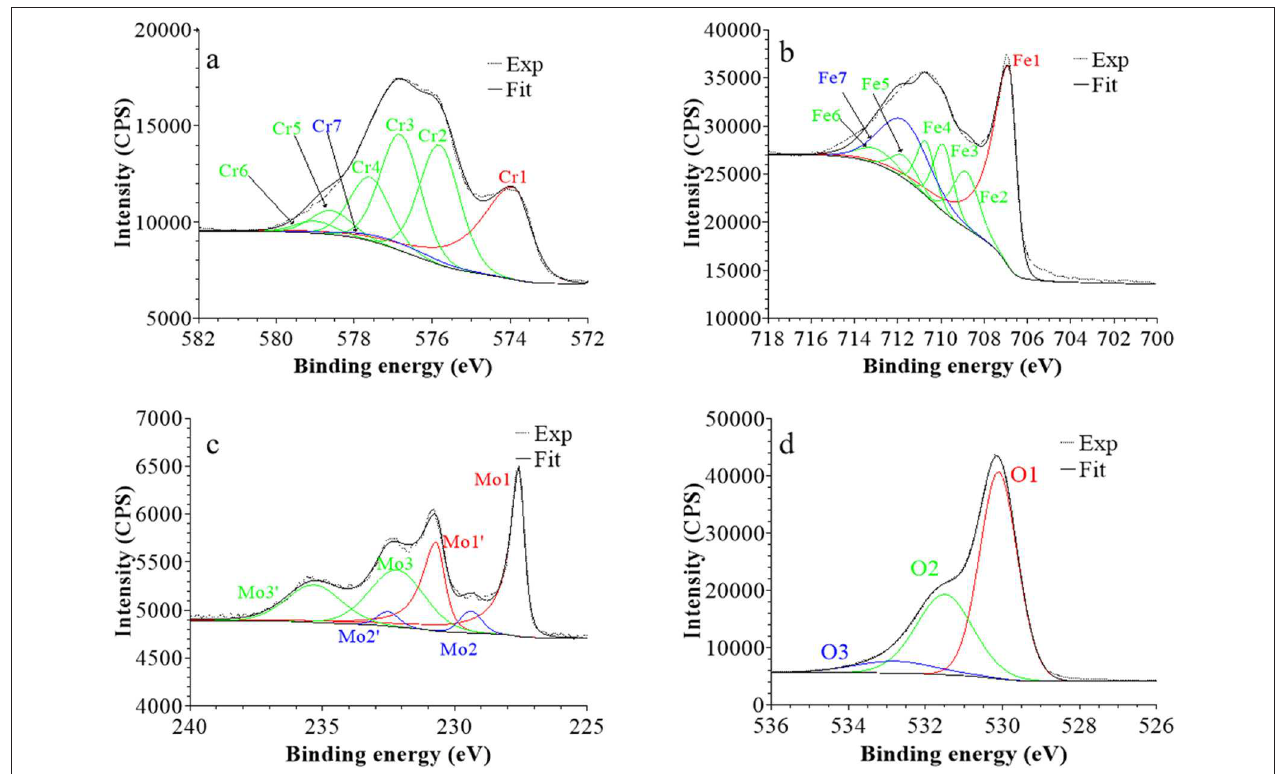
FIGURE 5 | XPS core level spectra and their reconstruction for the native oxide film on 316L SS: (a) Cr 2p 3 / 2, (b) Fe 2p 3 / 2, (c) Mo 3d 5 / 2 − 3 / 2 , and (d) O 1s regions (take-off angle: 90 ◦